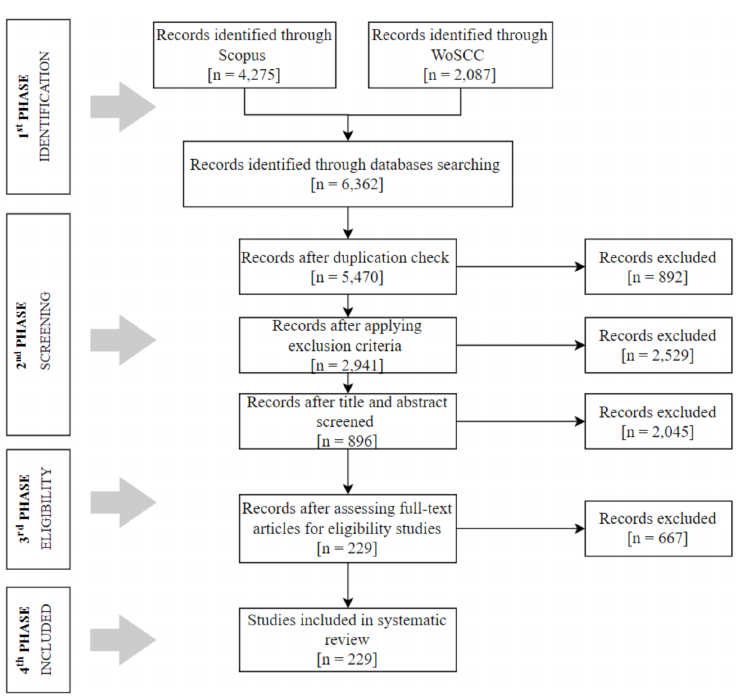
Figure 1. The PRISMA flow diagram for this systematic